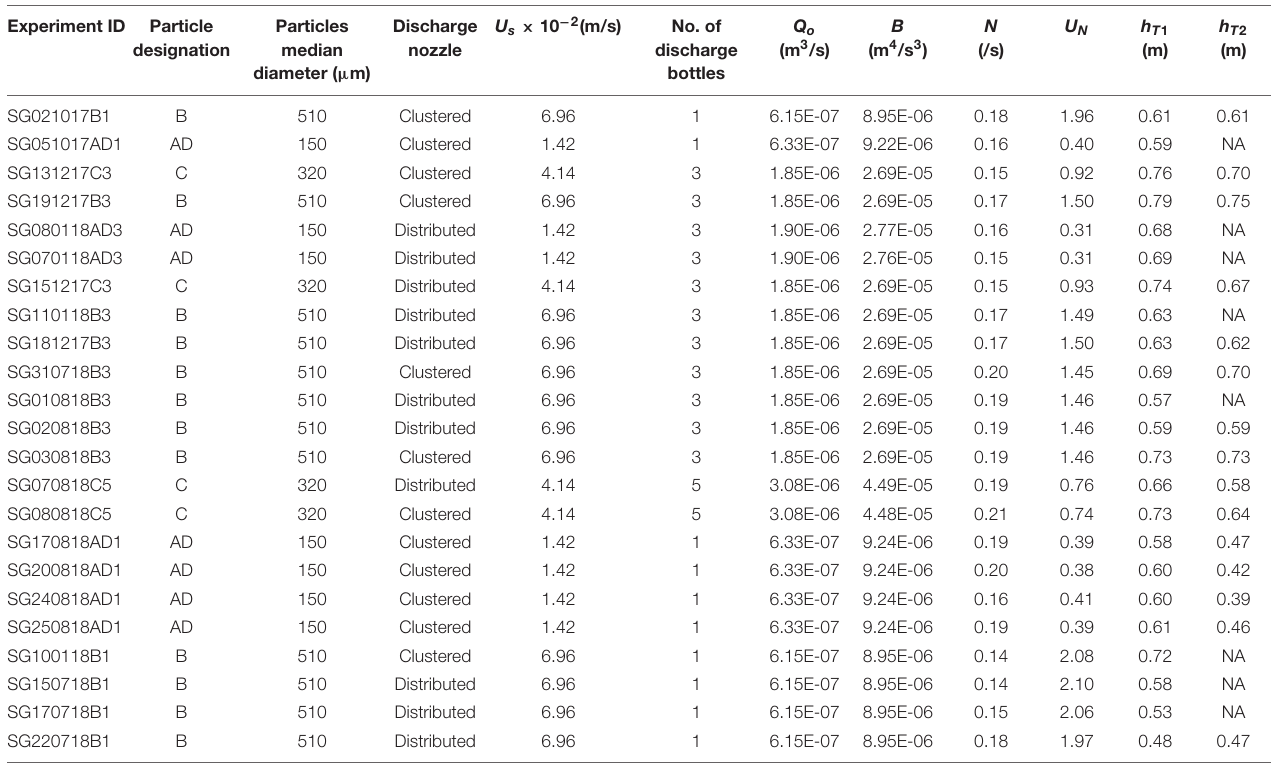
TABLE 1 | Experiment conditions for plume intrusion investigation in stratified, stagnant ambient. Experiment ID Particle